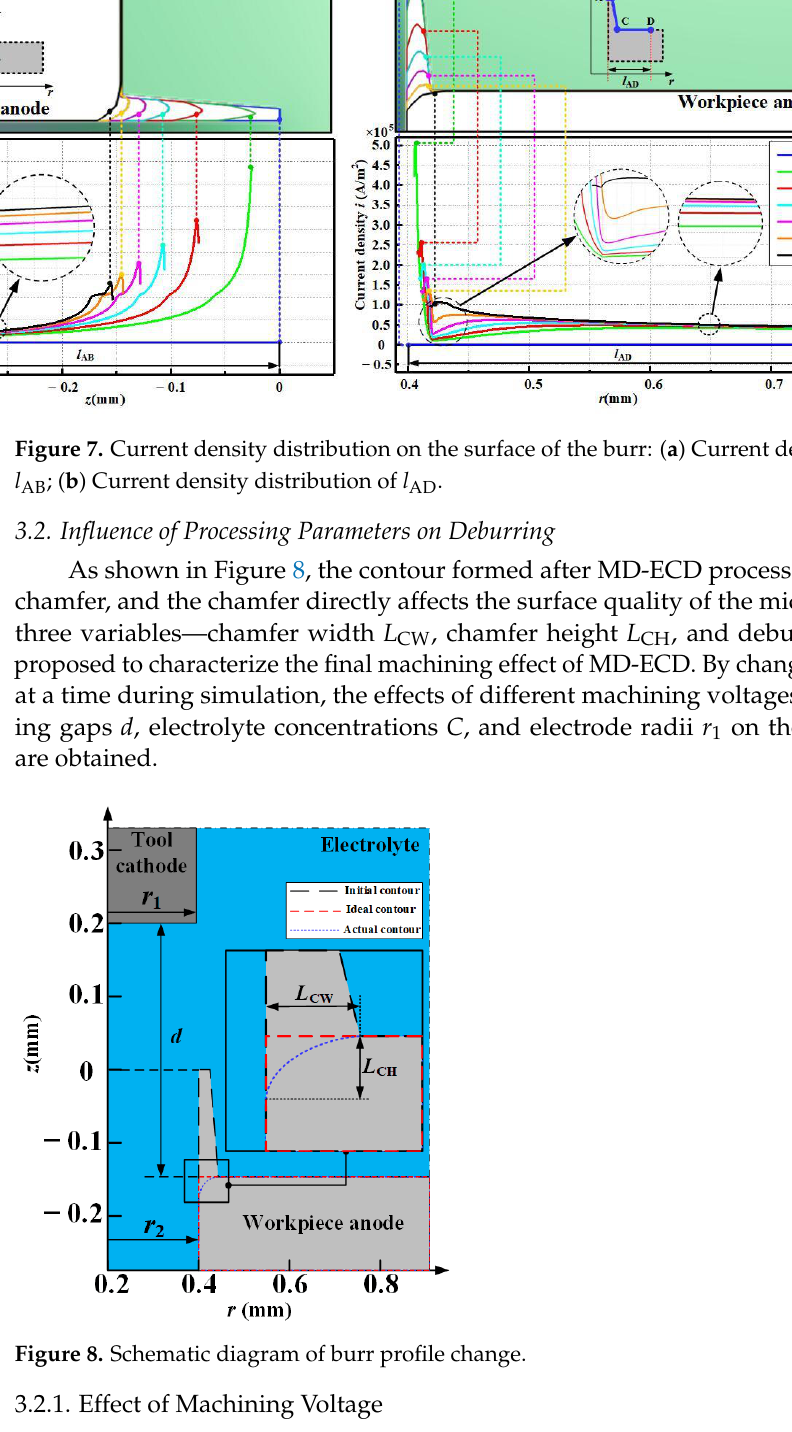
Figure 9. Effect of machining voltage: ( a ) Current density distribution of l AB ; ( b ) Current density distribution of l AD . 3.2.2. Effect of Initial Machining Gap The effect of the initial machining gap is shown in Figure 10. It can be seen from the figure that when other machining parameters remain unchanged, the current density value distributed on the l AB segment and the l AD segment is inversely proportional to the initial machining gap, which is consistent with the result of Equation (12). As the machin-